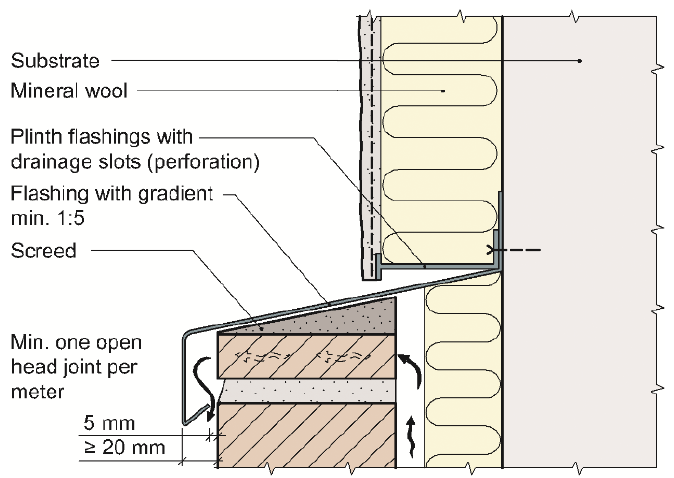
Figure 8. Example of a moisture-resistant wall finishing against a balcony.